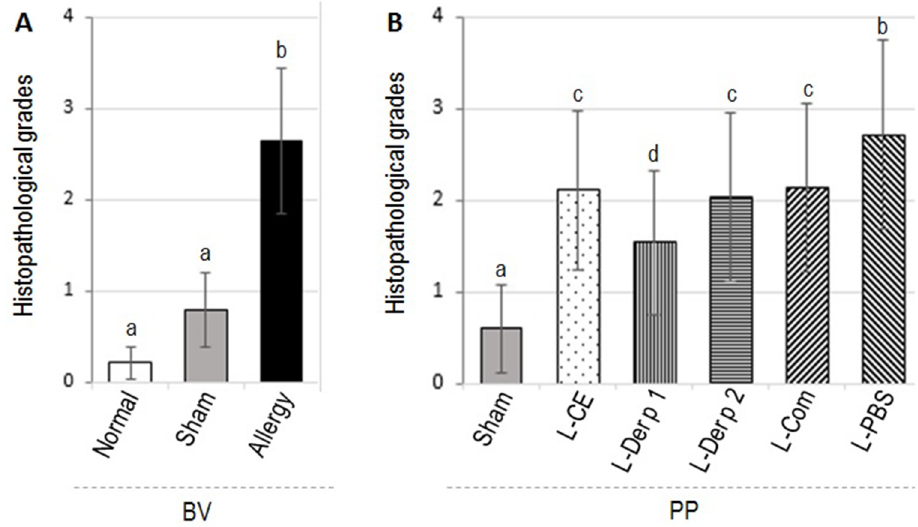
Fig 3. Histopathological grades (mean ± SD) of lung tissues of (A) allergenized, sham and normal mice (BV) and (B) allergenized mice that receivedvaccines/placebo followed by provocation (PP). Bars with different letters (a and b in A) and (a, b, c, and d in B) are statistically different at p (cid:20)